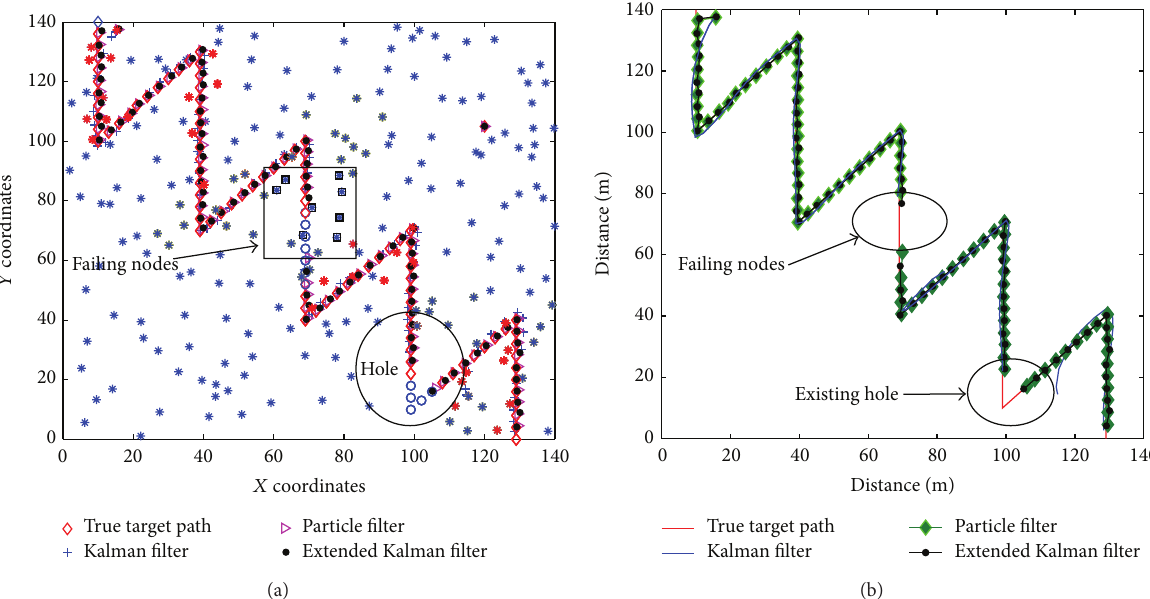
Figure 6: (a) Loss of target due to communication failure—Case I trajectory. (b) Loss of target due to communication failure—Case I graph.